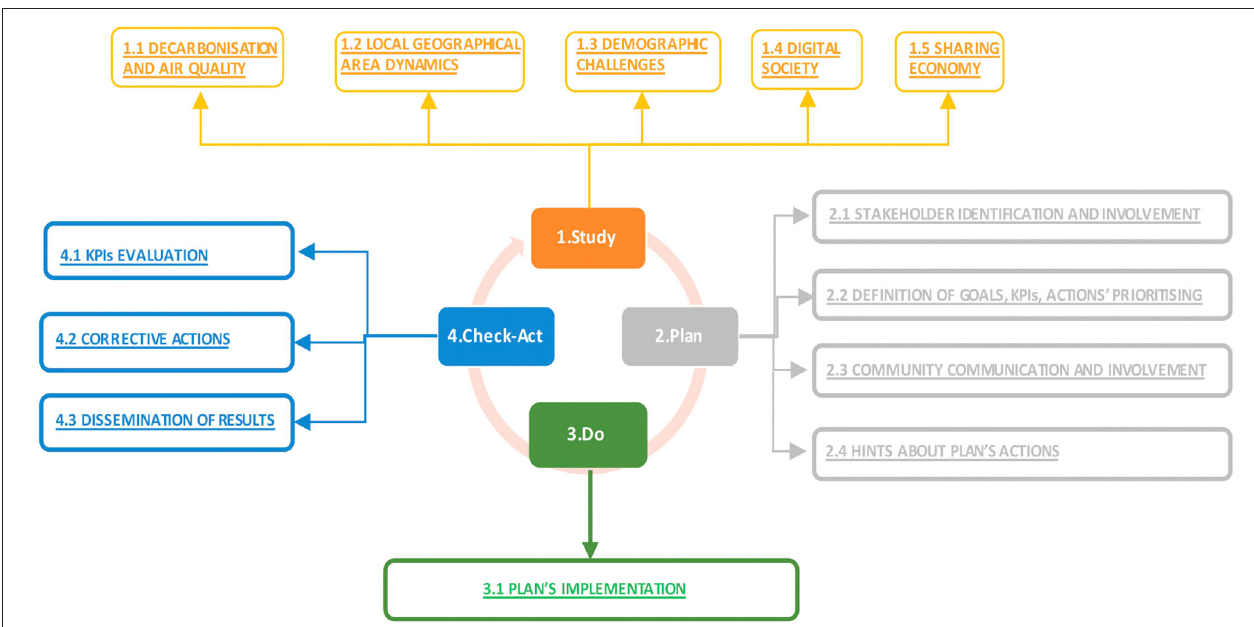
FIGURE 1 | Proposed CAMP-sUmp Action Plan overview (Regattieri et al.,